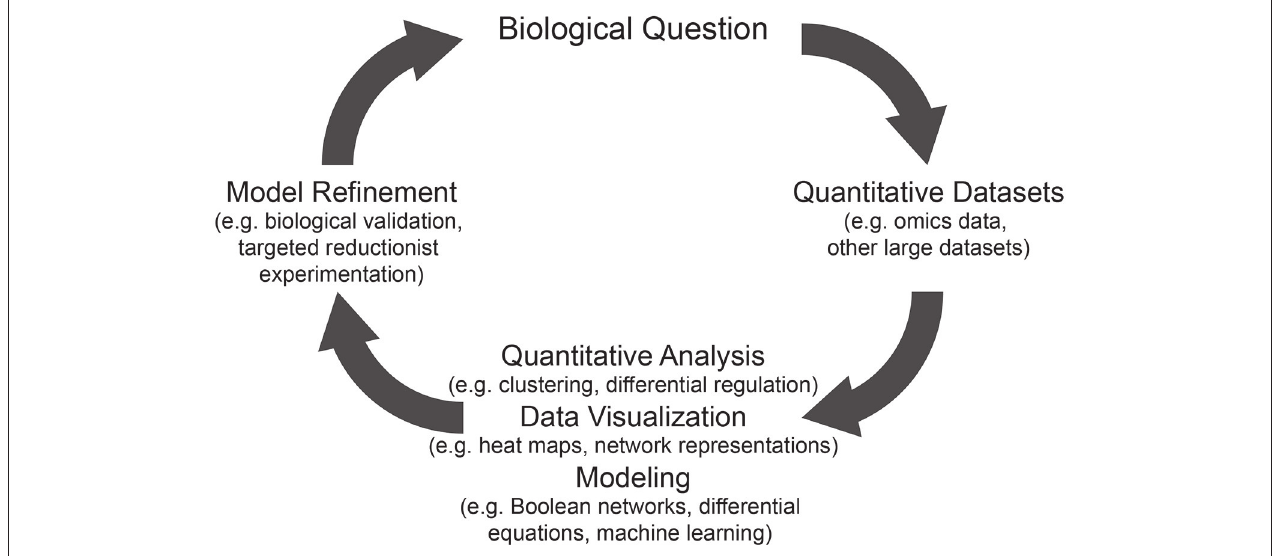
FIGURE 2 | The processes involved in generating systems biology-informed models. To inform the biological question, quantitative datasets are generated, which are then used in quantitative analysis, data visualization, and modeling to describe how the system behaves. These tools can be used interchangeably and/or in succession before further refining the model. Refinement of the model can then provide new biological